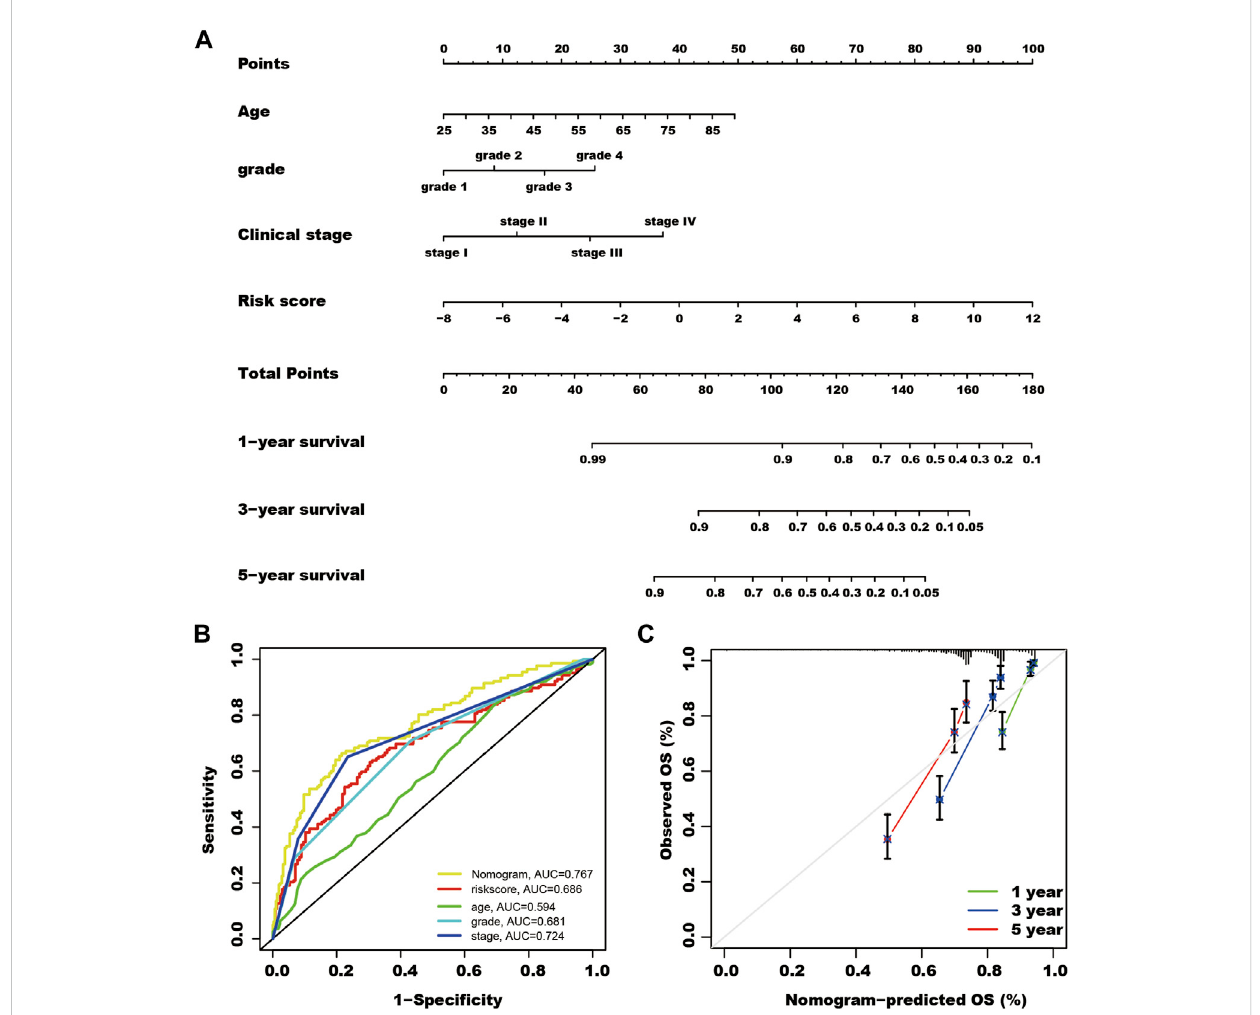
FIGURE 5 A nomogram for predicting the survival rate of kidney cancer patients. (A) Using multivariate cox regression results of the total The Cancer Genome Atlascohort,patientage,Grade,clinicalstage,andSUMOylationriskscoreshowindependentriskfactorsofpatientoutcomes.Eachfeaturewasassigned a value, and the total value of patients corresponded to values of 1-, 3- and 5-year survival rates. (B) The nomogram shows the highest AUC value of in multi-ROC analysis. (C) Calibration curves of the nomogram for predicting the outcome of 1, 3, and 5 years in the total TCGA